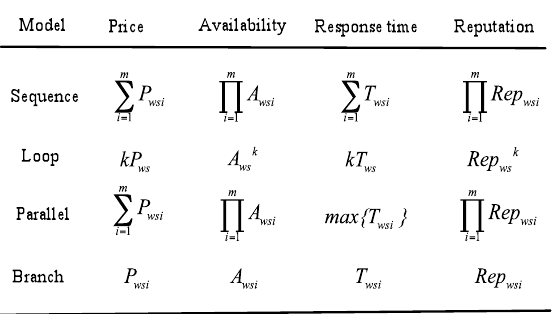
Table 1. QoS aggregate rules for composite